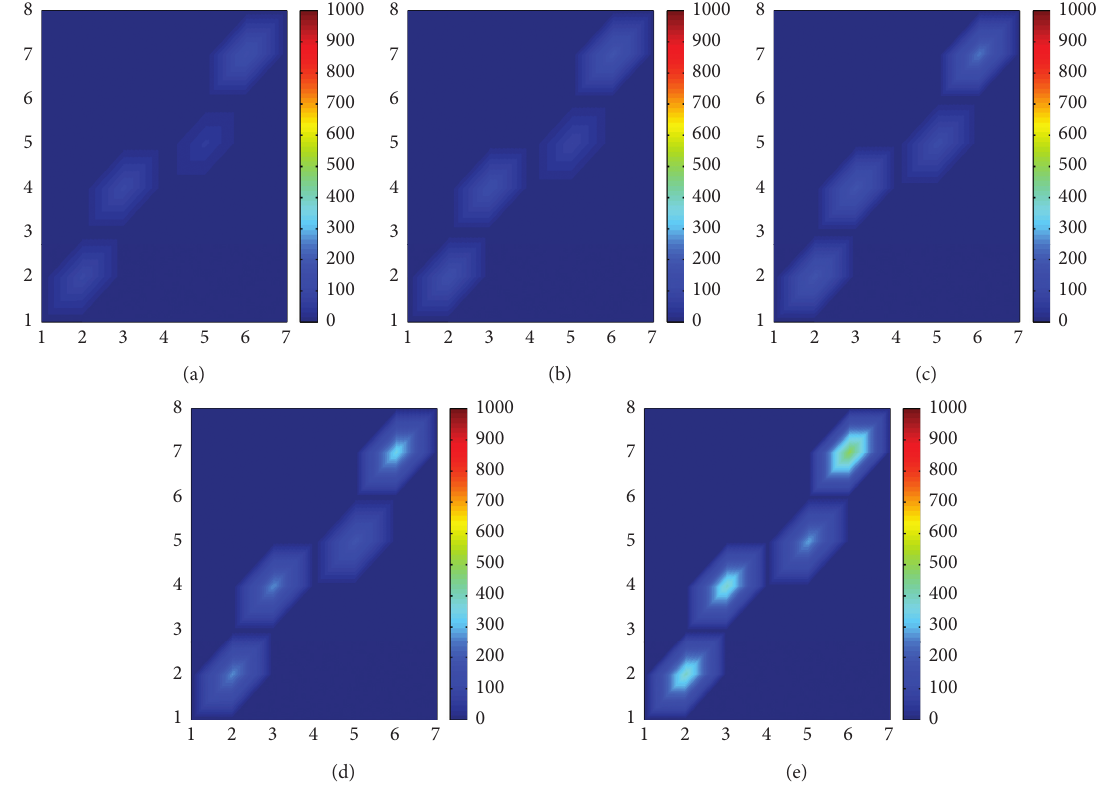
Figure 9: The biomass of top predator behavior within Ω with control u C pq . (a) t � 0. (b) t � 50. (c) t � 100. (d) t � 150. (e) t �